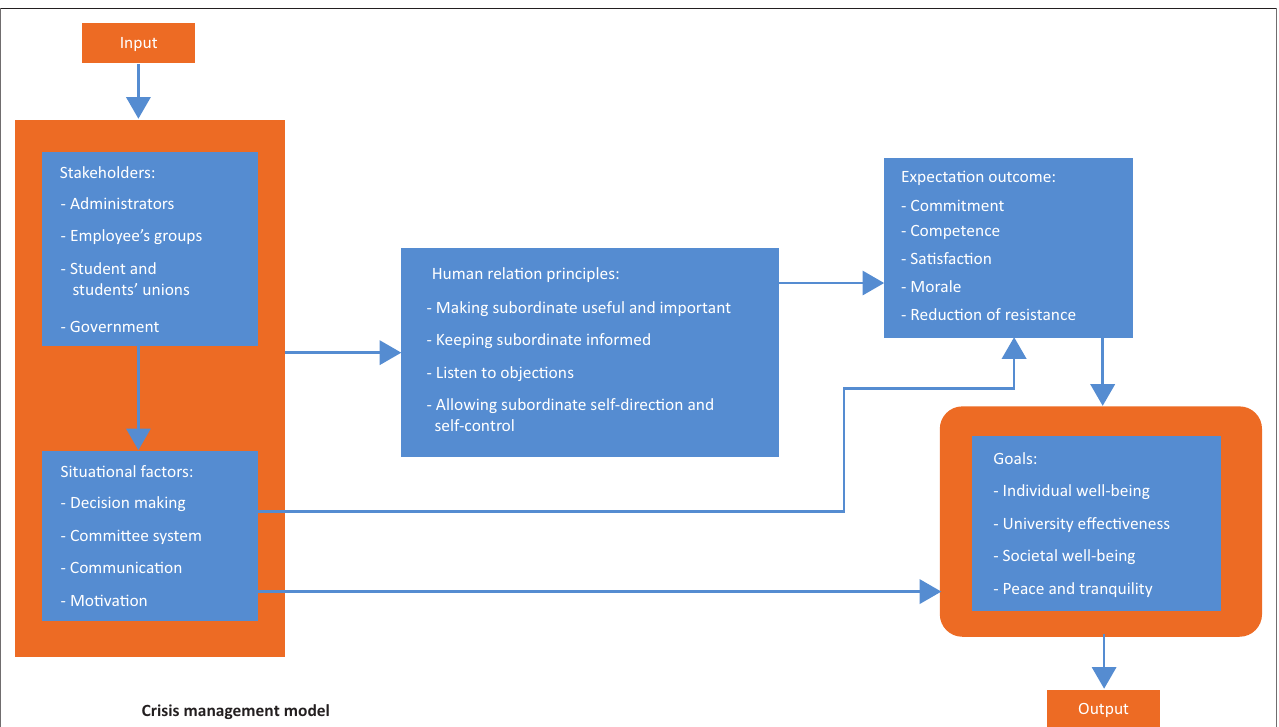
FIGURE 1: Crisis management